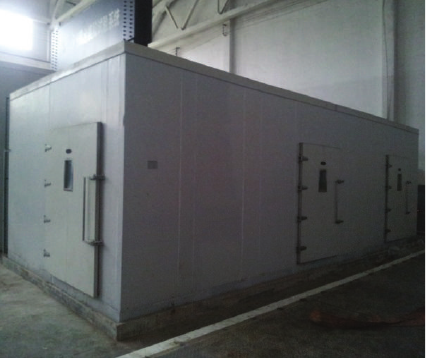
Figure 10: Permafrost natural environment simulation system. Table 4: Elastic modulus values of S-RM and FS-RM. Rock content